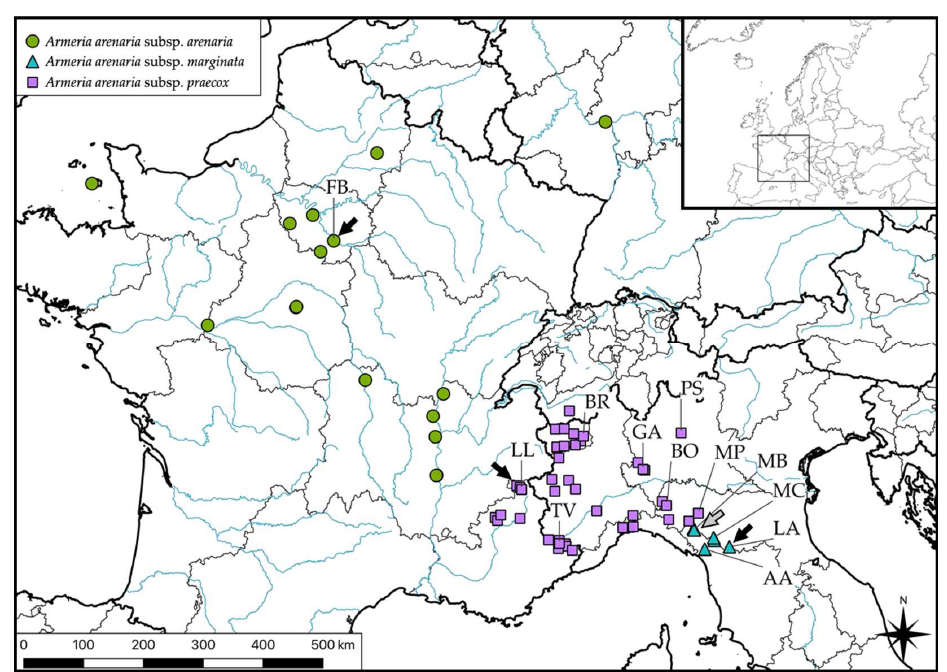
Figure 6. Distribution based on 81 herbarium specimens, including the localities sampled in this study, of Armeria arenaria subsp. arenaria , A. arenaria subsp. marginata , and A. arenaria subsp. praecox , as newly circumscribed. Solid arrows indicate type localities of the three taxa listed in the legend at the top–left corner on the map, whereas the crosshatched arrow indicates the type locality of A. arenaria subsp. apennina . Population codes as in Table 1.